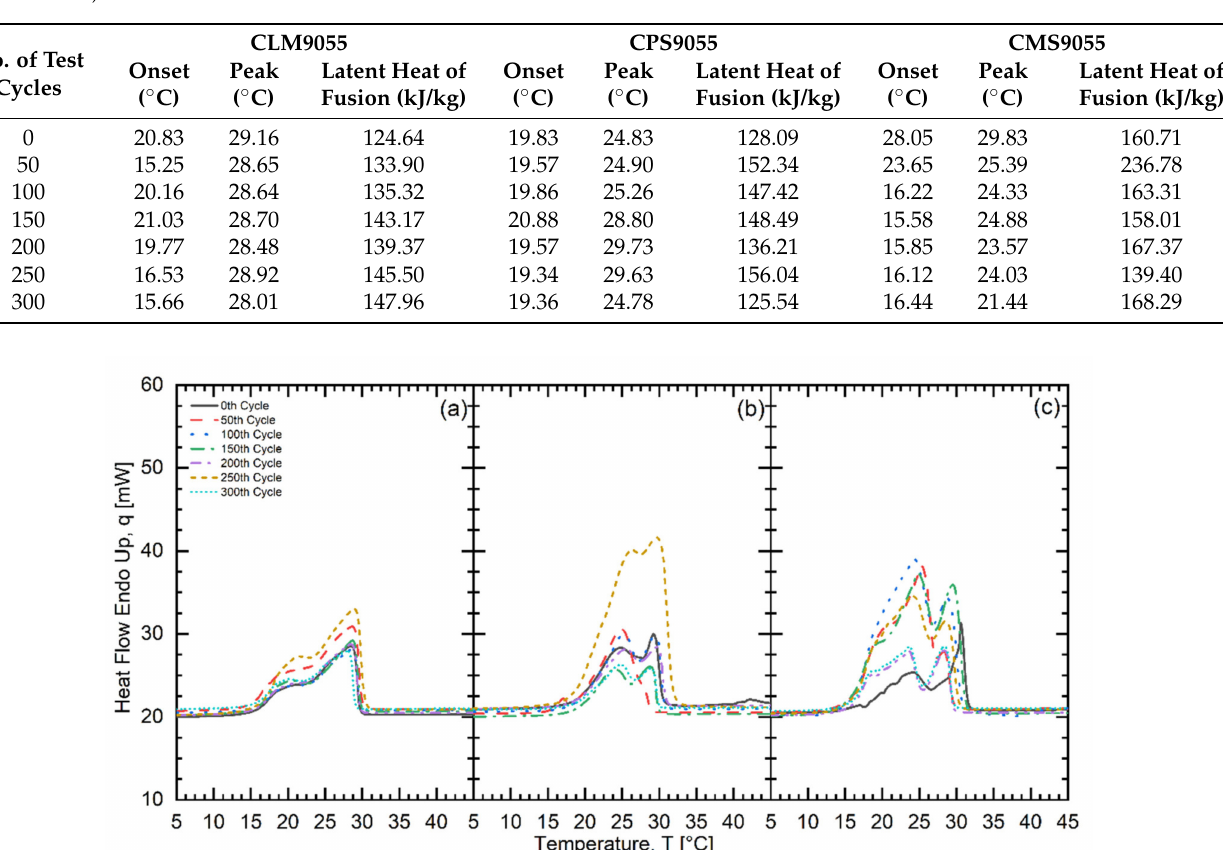
Table 11. Latent heat of fusion and melting temperature of developed materials with test cycles (CLM9055, CPS9055, CMS9055).